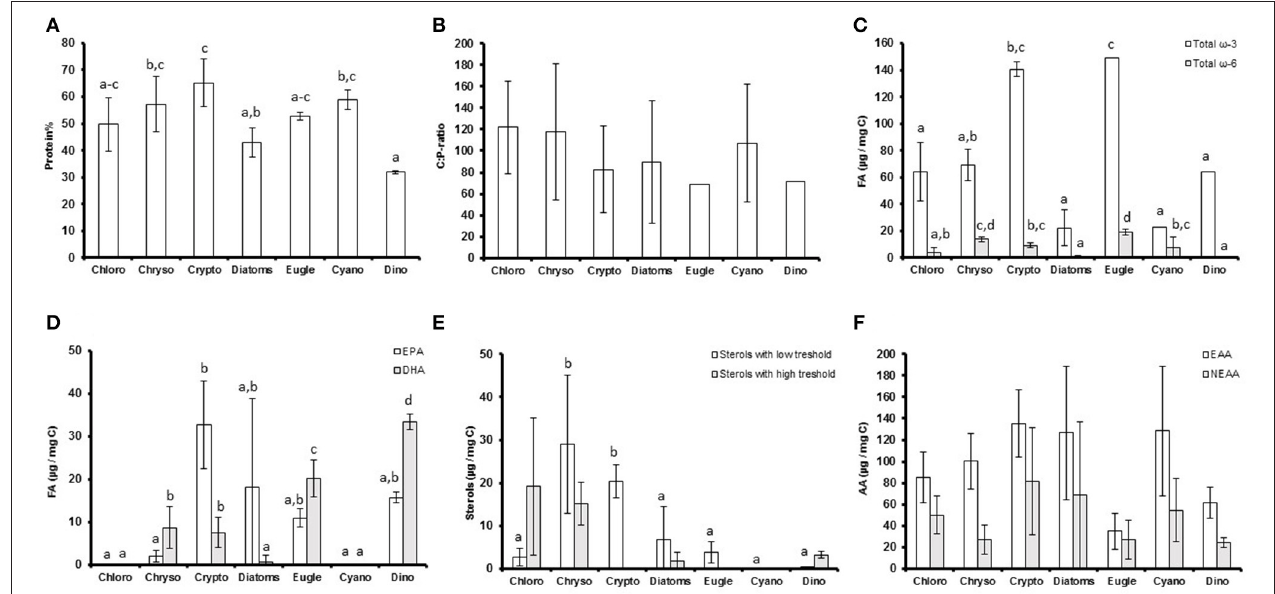
FIGURE 1 | (A) The protein percentages (protein%); (B) carbon to phosphorus (C:P) -ratios; (C) total ω -3 and ω -6 fatty acid concentrations ( µ g/mg C); (D) eicosapentaenoic acid (EPA) and docosahexaenoic acid (DHA) concentrations ( µ g/mg C); (E) the concentrations of low and high threshold sterols ( µ m/mg C) and; (F) amount of essential (EAA) and non-essential (NEAA) amino acids ( µ g/mg C) of the studied phytoplankton classes. Different letters (a–c in figs. A,E ; a–d in figures. C,D ) denote significant differences ( p < 0.05) between diets. The error bars are for standard deviations, and the number of strains in each class (n) can be found in Table 1 .